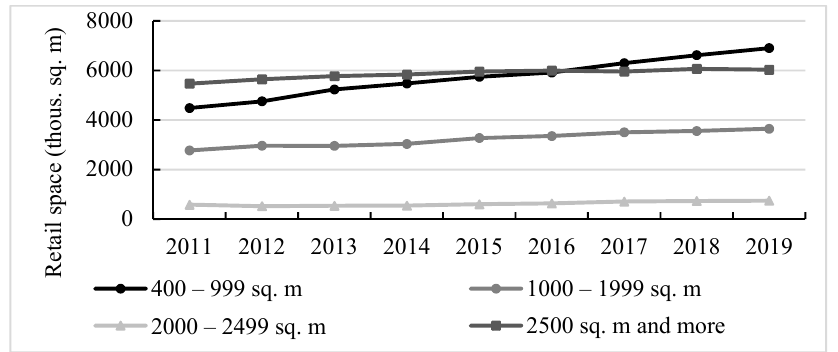
Figure 5. Retail space in Poland in 2011–2019 (as of December 31st). Source: own elaboration based on data from the Local Data Bank.